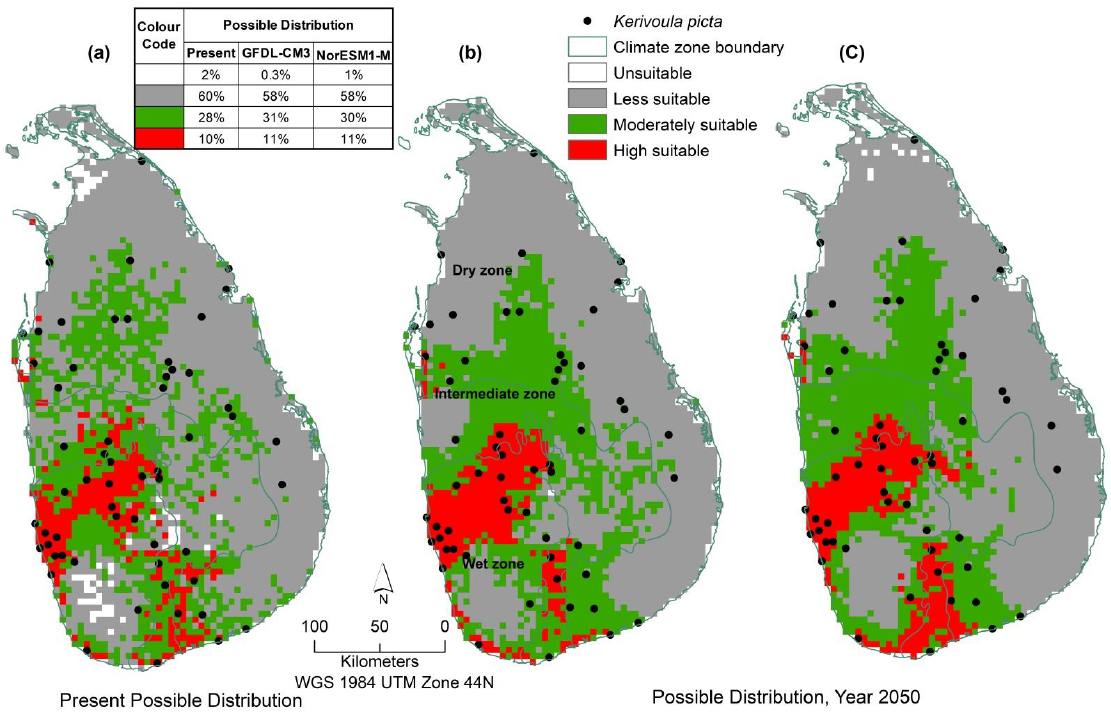
Figure 3. MaxEnt-based habitat suitability maps for current ( a ) and future (2050) distribution ranges based on GFDL-CM3 ( b ) and NorESM1-M climate change forecasts ( c ) for K. picta in Sri Lanka. Table tallies proportional changes in distribution acreage between current and future scenarios.